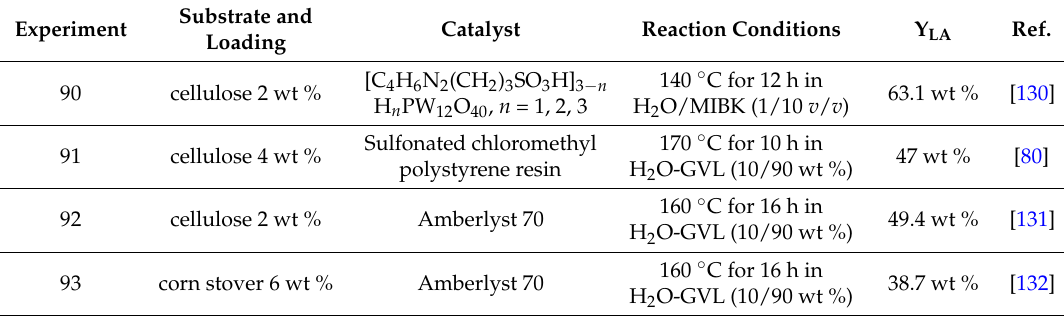
Table 6. Polysaccharides and raw and waste biomasses conversion in monophasic organic solvents: reaction